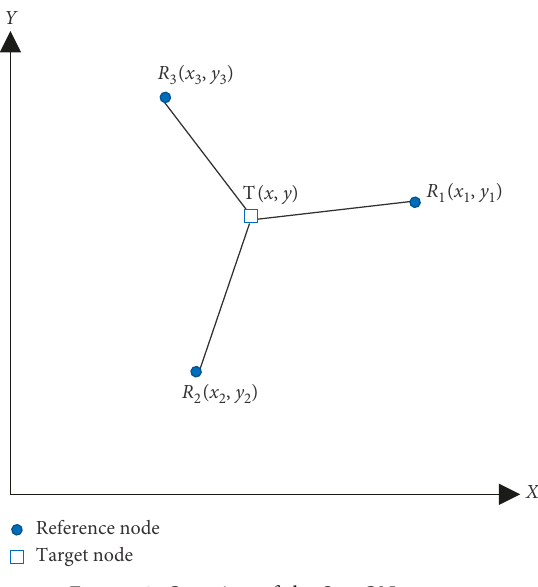
Figure 2: Overview of the SpotON system.